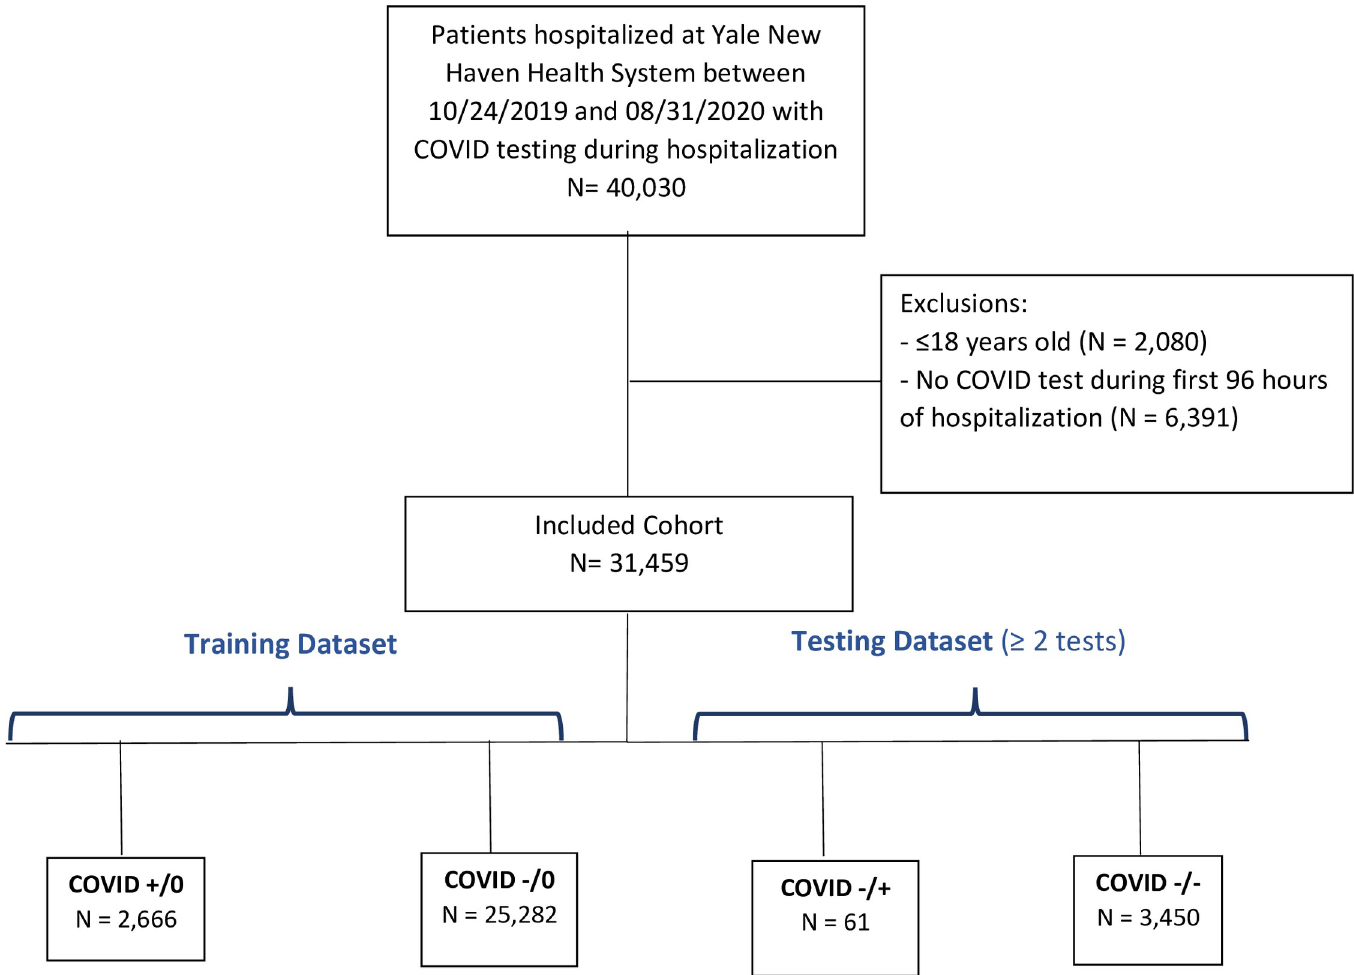
Fig 1. Cohort diagram. COVID +/0: tested positive for COVID on admission and was not retested within 4 days. COVID -/0: tested negative for COVID on admission and was not retested within 4 days. COVID -/+: tested positive for COVID on admission and upon retesting (within 4 days) tested positive for COVID. COVID -/-: tested negative for COVID on admission and upon retesting (within 4 days) tested negative for COVID.